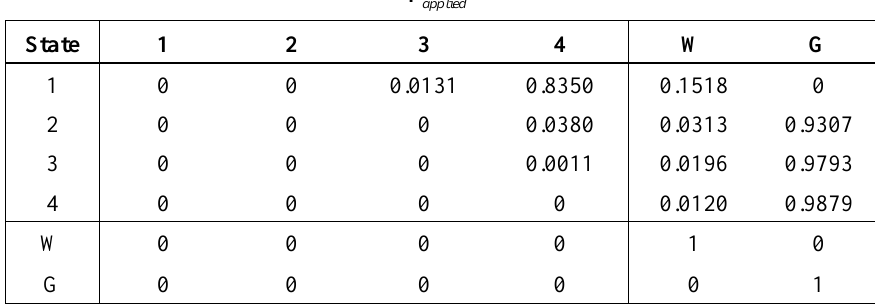
Table 17. The estimated transition probabilities matrix of applied sciences program for